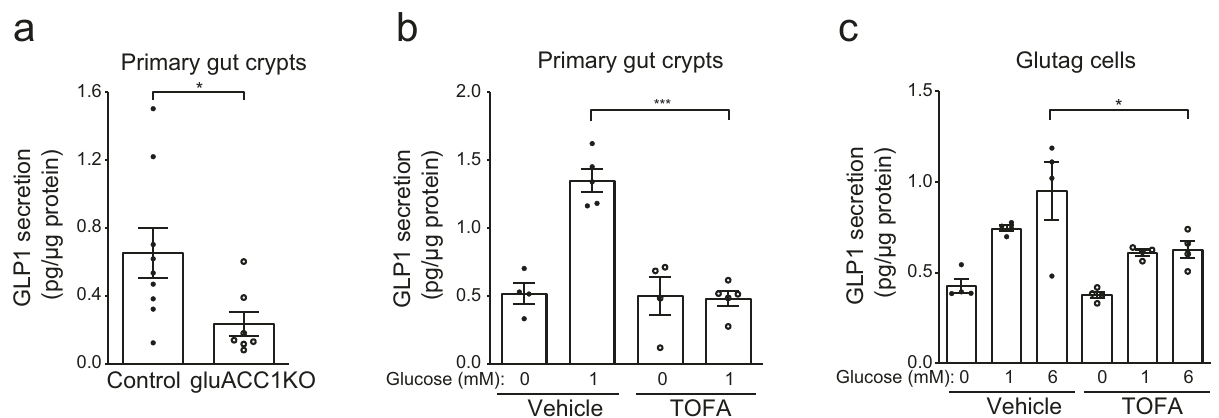
Fig. 3 Inactivation of ACC1 impairs glucose-stimulated active GLP-1 secretion. a Primary gastrointestinal (GI) crypts were isolated from 20- to 24-week old control (black circles) and gluACC1KO (white circles) mice and secretion of active GLP1 was quanti fi ed ex vivo in the presence of 1 mmol/l glucose, and normalised to the total protein content of each well. Data from n = 7 – 9 independent preparations analysed by t -test. b Active GLP-1 secretion from primary wild-type (C57Bl6/J) GI crypts treated with the ACC inhibitor TOFA (white circles) or vehicle (black circles), and the indicated glucose concentrations. Data from n = 5 independent preparations analysed by t -test. c Active GLP-1 secretion from transformed Glutag cells treated with TOFA or vehicle, in the presence of the indicated glucose concentrations. Data from n = 4 independent experiments were analysed by one-way ANOVA with Tukey ’ s